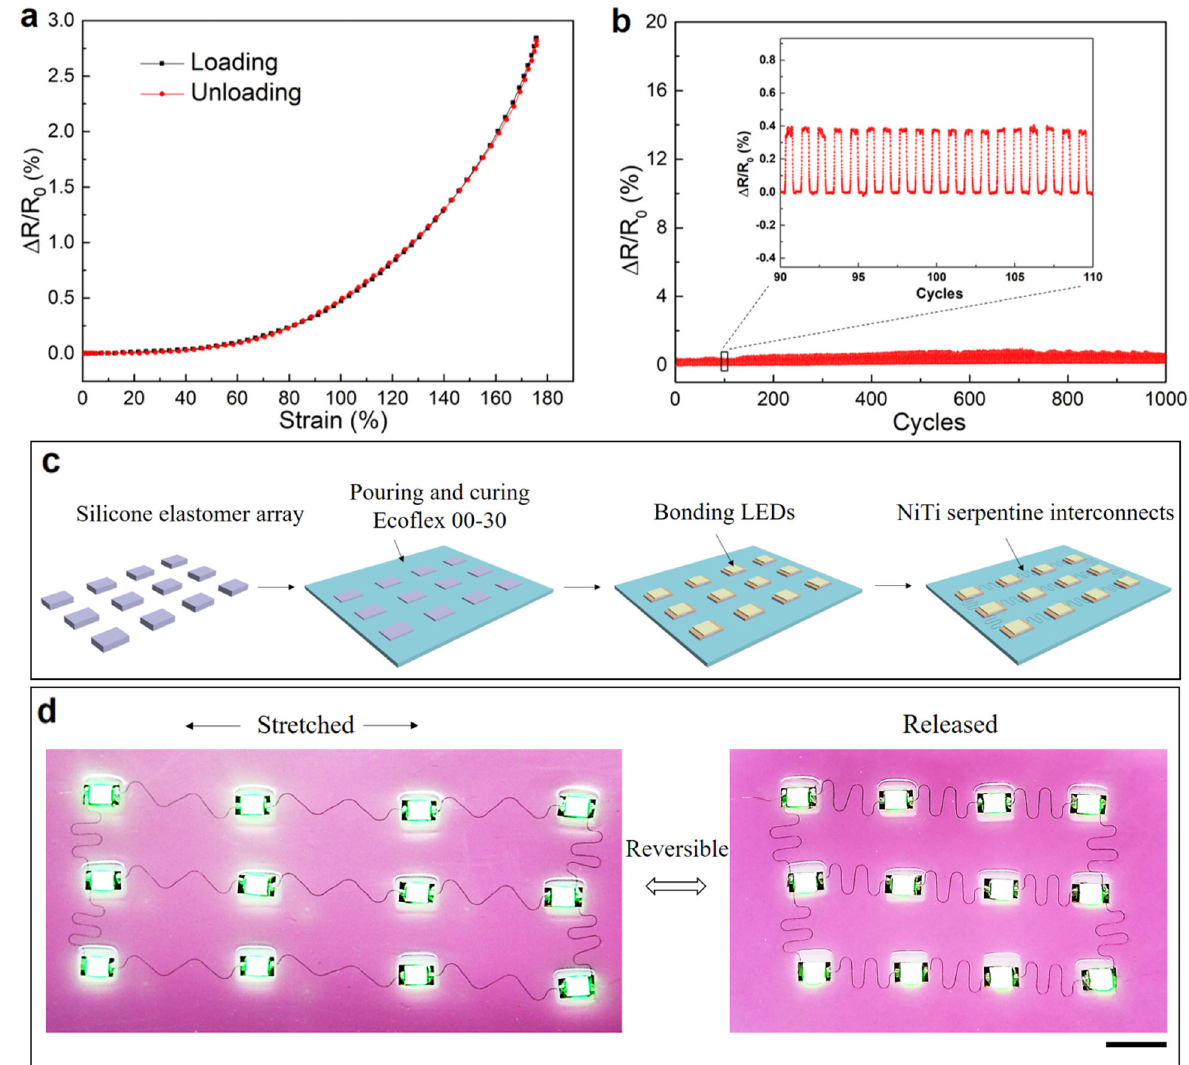
Fig. 6 Electrical properties and stretchable LED array device. a Relative resistance change of the Ni-Ti interconnect as a function of applied strain, showing a negligible hysteresis behavior when loading and unloading. b Relative resistance change under cyclic stretching from ε = 0% to ε = 100% with a frequency of 0.025 Hz over 1000 cycles, the inset shows a zoomed-in image of relative resistance change between cycle 90 and 110. c Stretchable LED array device fabrication fl ow chart. d Optical image of the LED array device under stretching, the scale bar is 10 mm. Pink paper was used as the background to make the interconnects